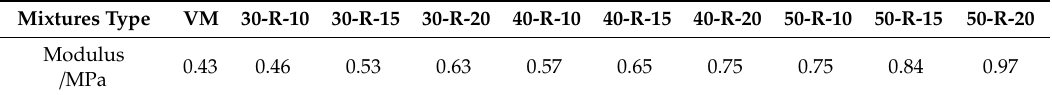
Figure 4. The tensile strain of mixture with different reclaimed asphalt pavement (RAP) and fine reclaimed asphalt pavement (FRAP) contents. Table 10. The modulus of mixtures with di ff erent reclaimed asphalt pavement (RAP) and fine reclaimed asphalt pavement (FRAP)